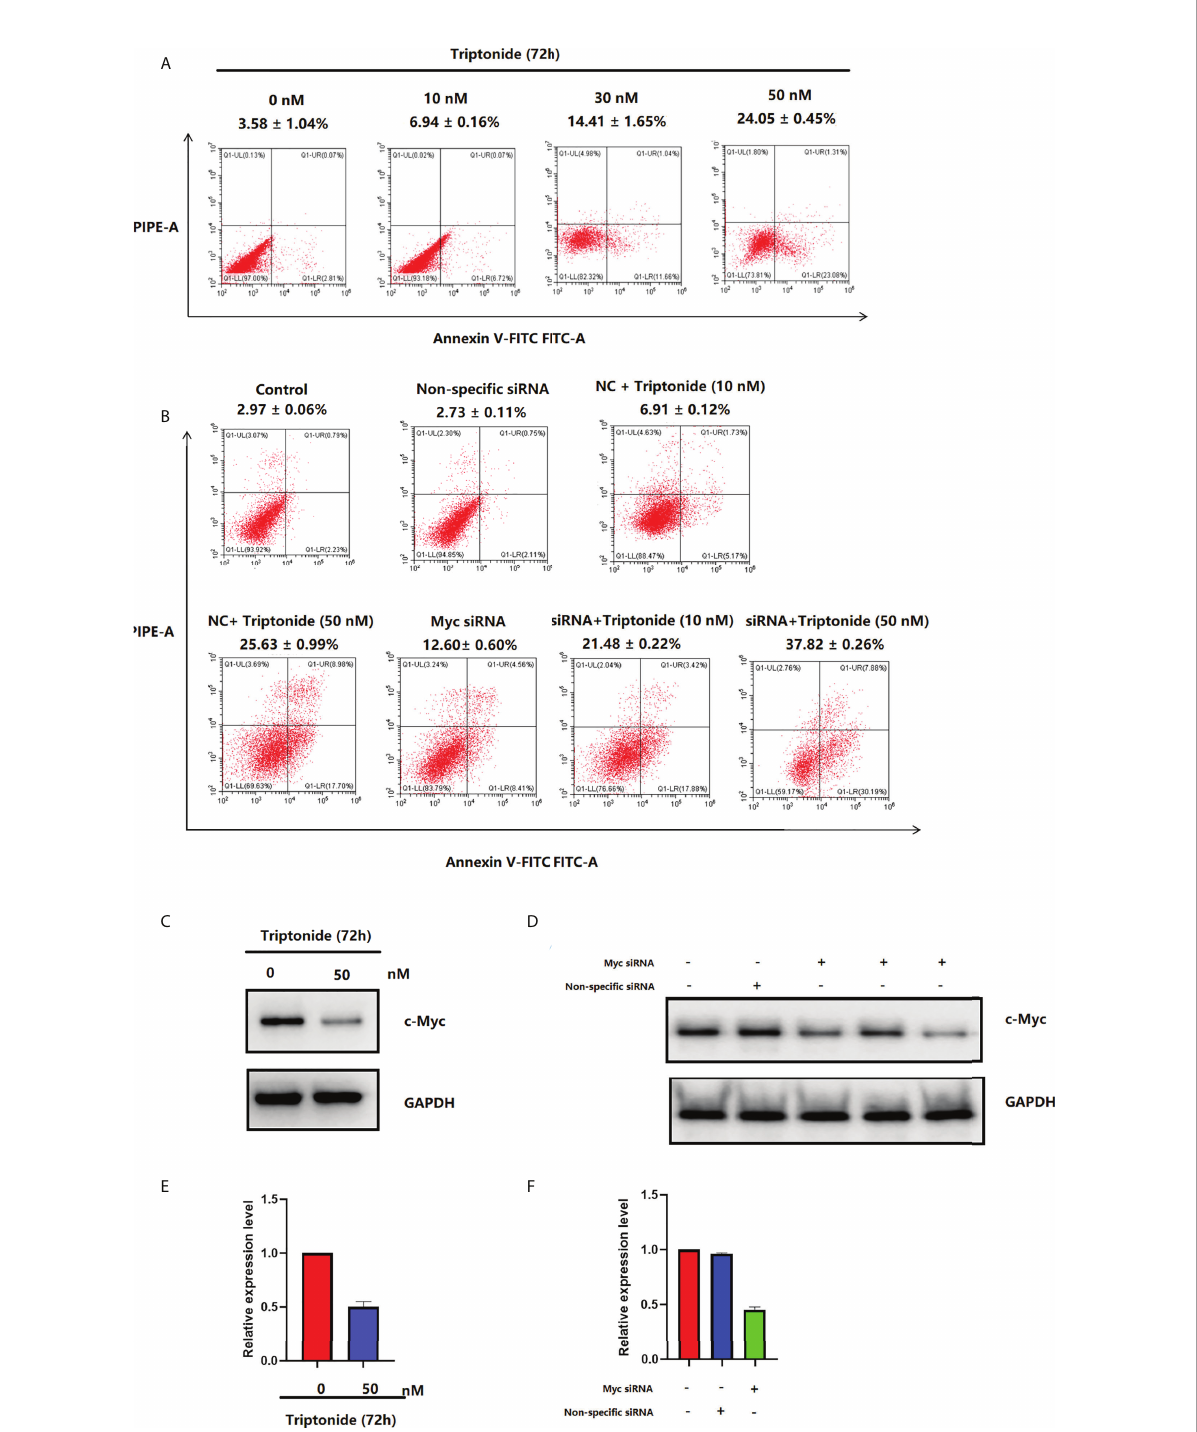
FIGURE 7 (A) Triptonide induces cell apoptosis. (B) c-Myc siRNA transfection induces cell apoptosis. (C) c-Myc levels in CAL-27 cells after treatment with triptonide, assessed by western blot. (D) The expression of c-Myc measured by western blot after c-Myc siRNA transfection. (E) c-Myc levels in CAL-27 cells after treatment with triptonide, assessed by RT – PCR. (F) The expression of c-Myc measured by RT – PCR after c-Myc siRNA